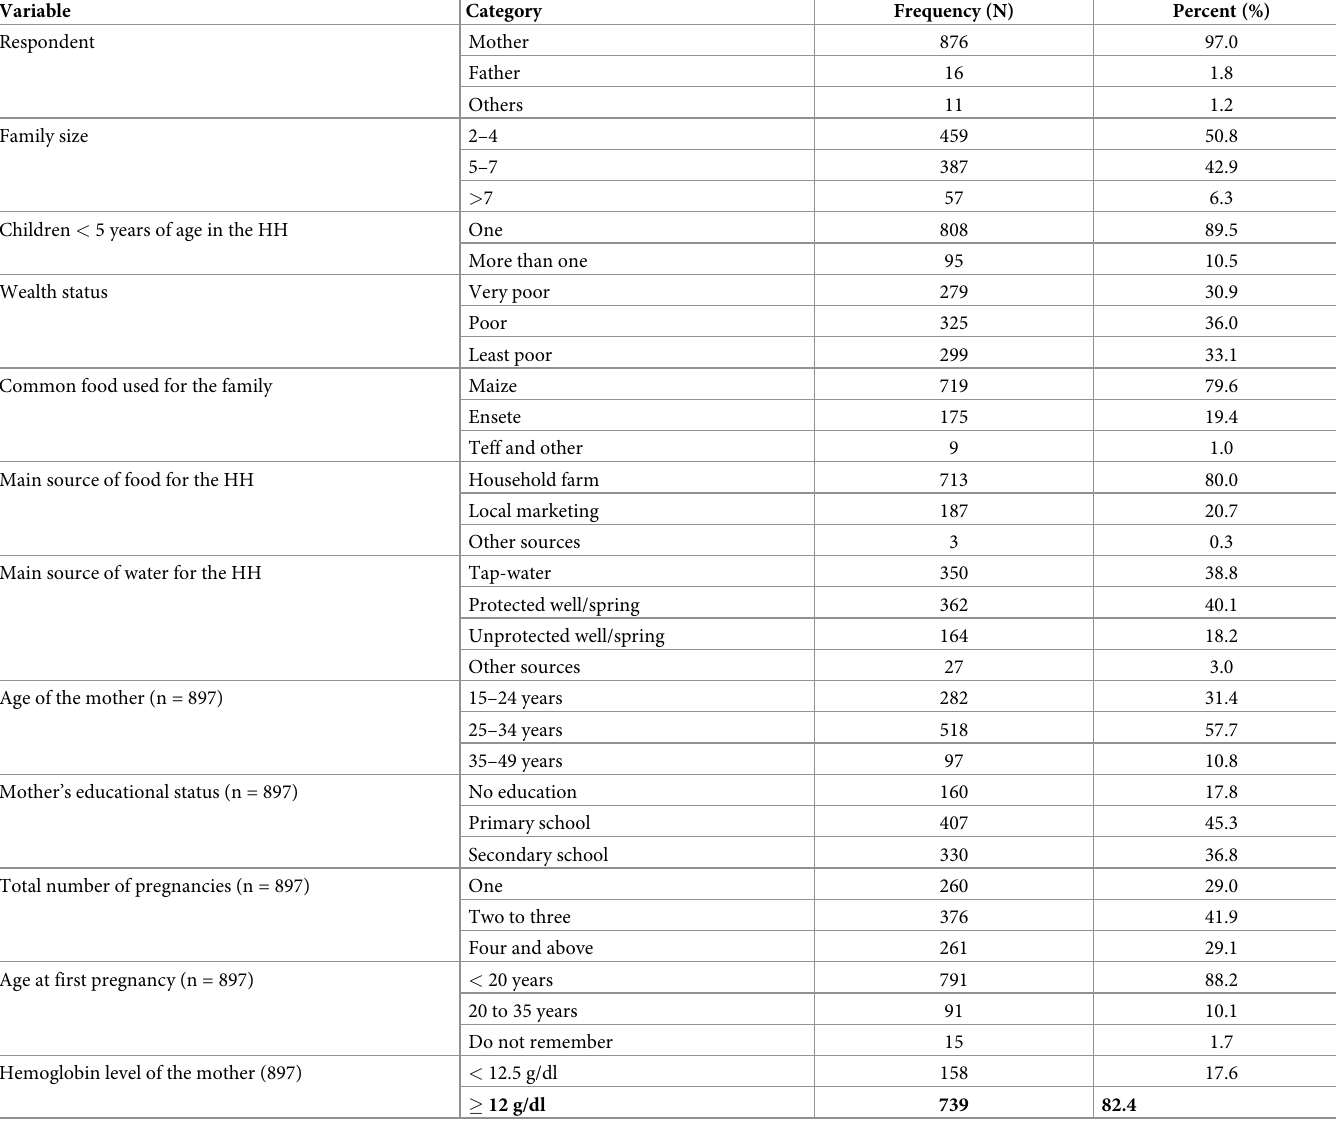
Table 1. Household factors and characteristics of mothers of the study children in Dale district, Ethiopia, 2018 (n = 903, except where otherwise